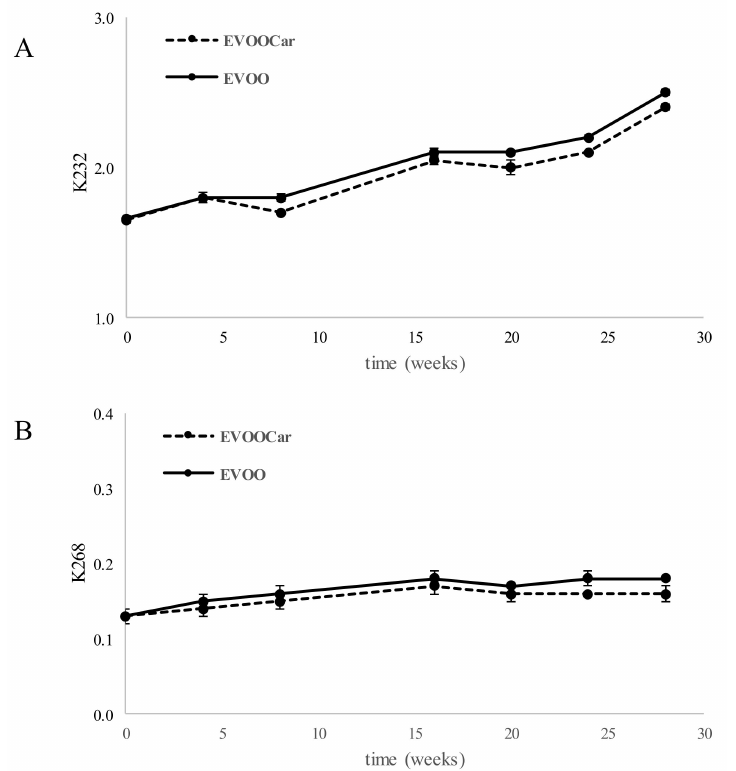
Figure 3. Trend of K232 ( A ) and K268 ( B ) of EVOO and EVOOCar during long-term storage (mean values). Error bars refer to the standard deviations ( n =